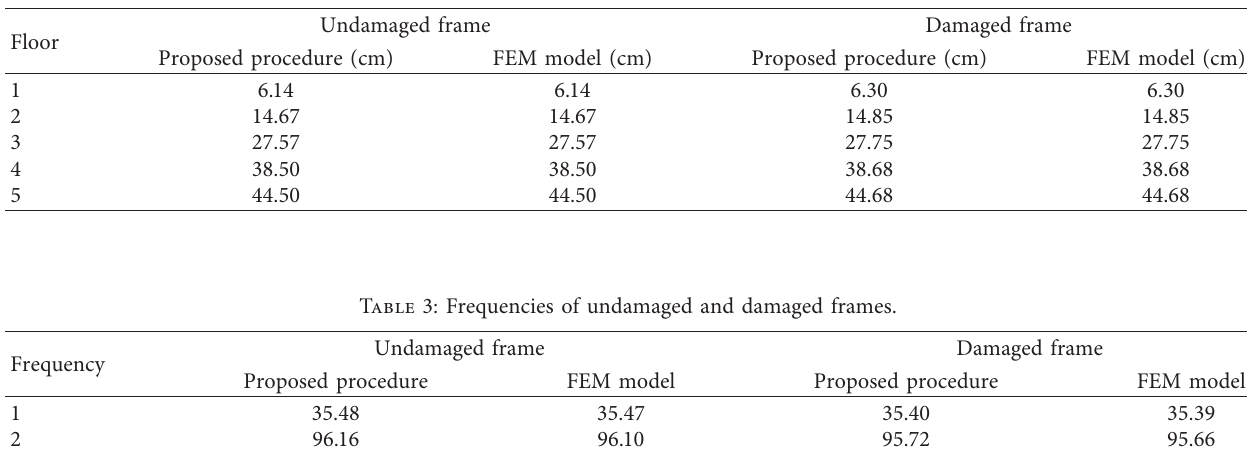
Table 2: Floor displacements of undamaged and damaged frames.